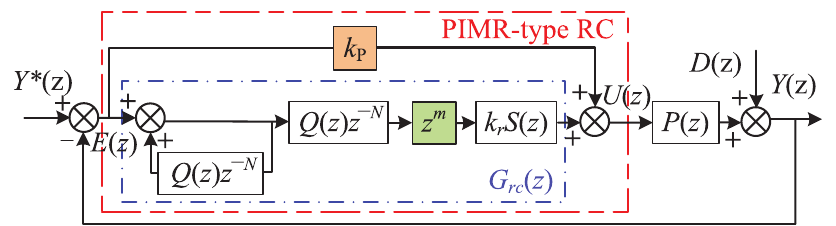
Figure 1. Control scheme of the PIMR-type